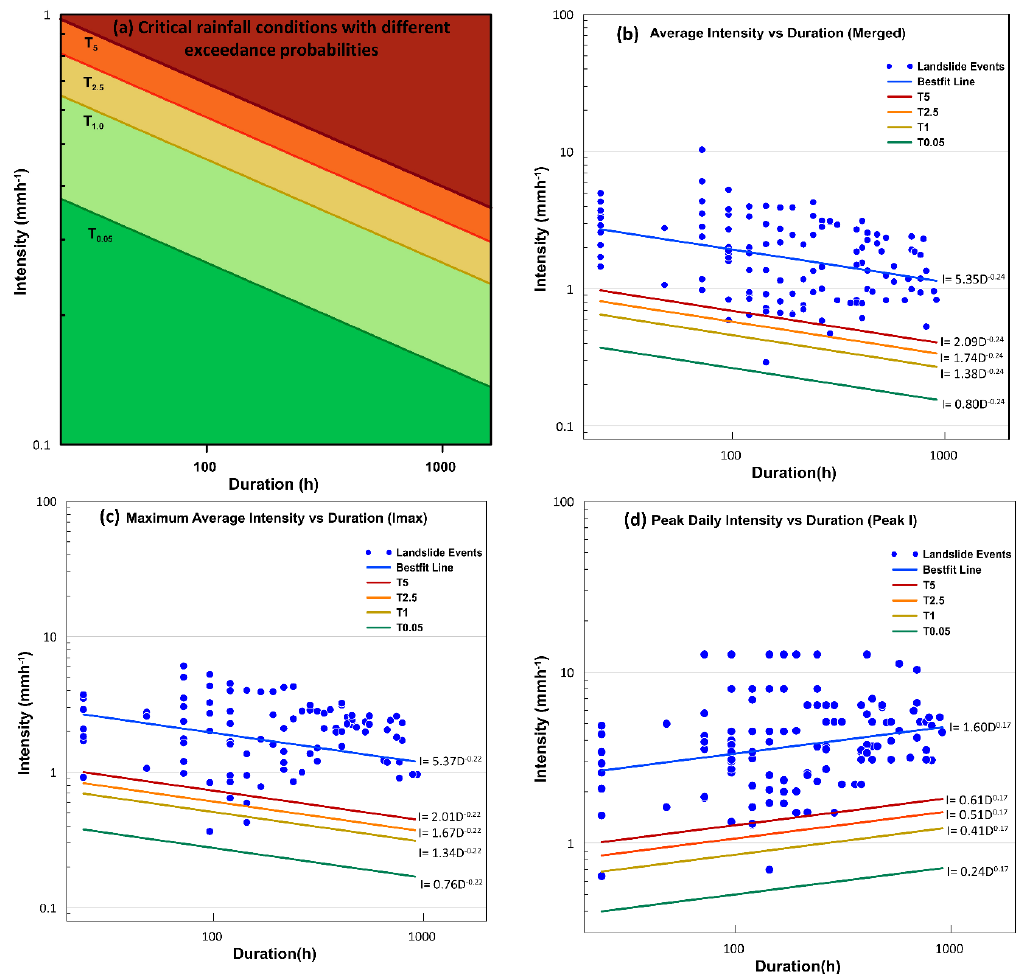
Figure 8. Regional scale intensity–duration thresholds established for Wayanad with different exceedance probabilities. ( a ) Critical rainfall conditions with different exceedance probabilities, ( b ) Average intensity vs duration (Merged), ( c ) Maximum average intensity vs duration (Imax), ( d ) Peak daily intensity vs duration (Peak I).